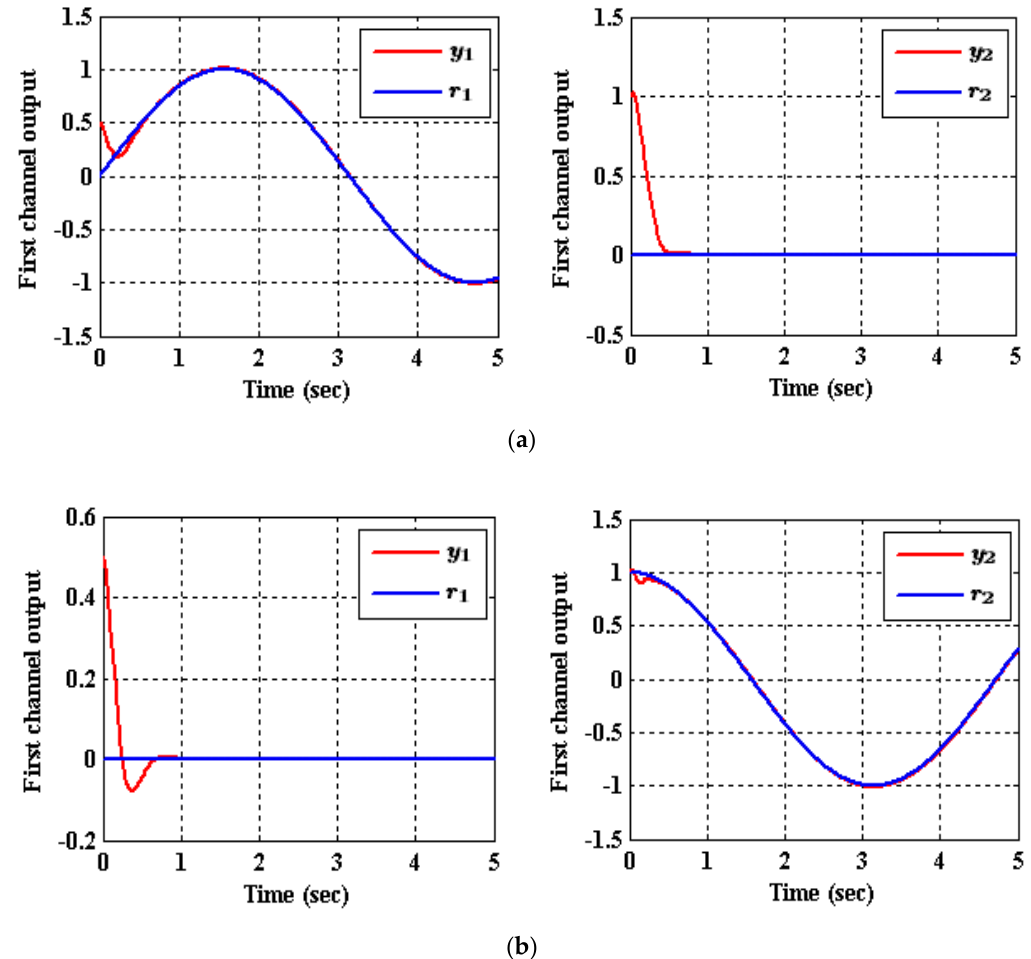
Figure 13. The output tracking of (42) due to reference inputs r 1 and r 2 , using a decentralized control scheme with IADRC, ( a ) ( r 1 , r 2 ) = ( sin ( t ) ,0 ) ; ( b ) ( r 1 , r 2 ) = ( 0,cos ( t )) .